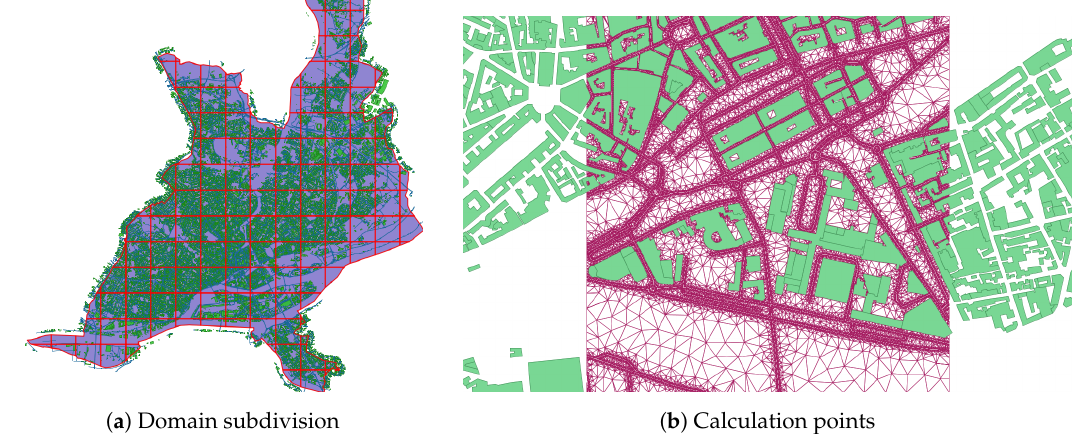
Figure 3. Illustrations of: ( a ) the decomposition of the domain into sub-domains; and ( b ) the definition of the calculation points on the basis of an adaptive meshing of a